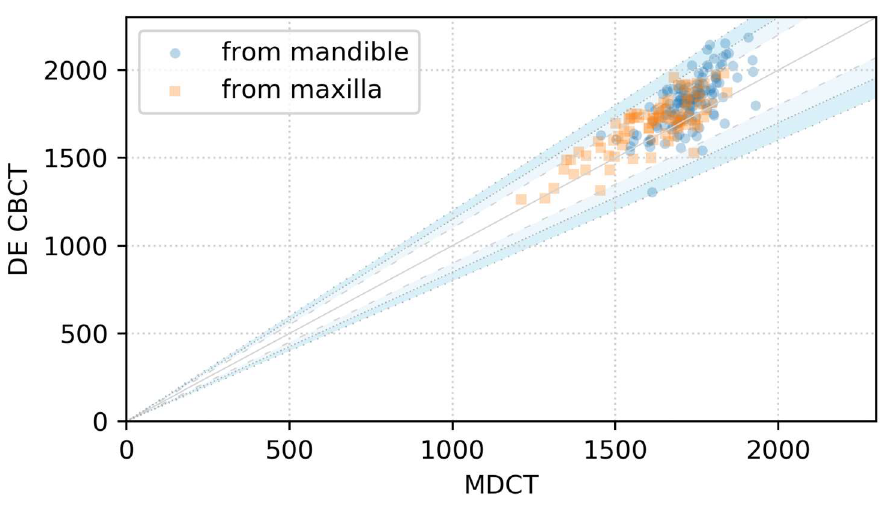
Figure 5. Scatter plot with the identity line and deviation ranges. Table 2. Deviation ranges and region of interest (ROI) numbers and percentages within each devia- tion